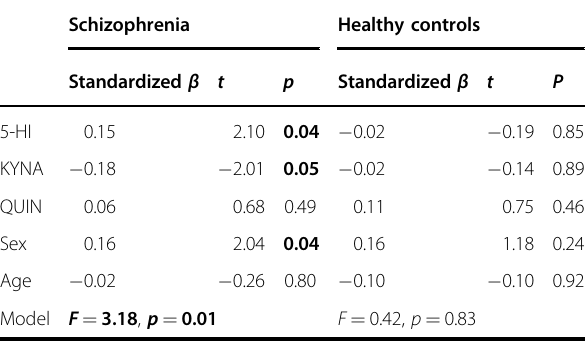
Table 2 Multiple regression analysis results of serum levels of 5-HI, KYNA, and QUIN on working memory